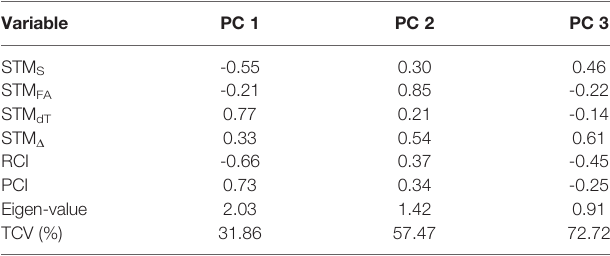
TCV, total cumulative variance; PC, principal component. See STM traits abbreviations in Figure 2